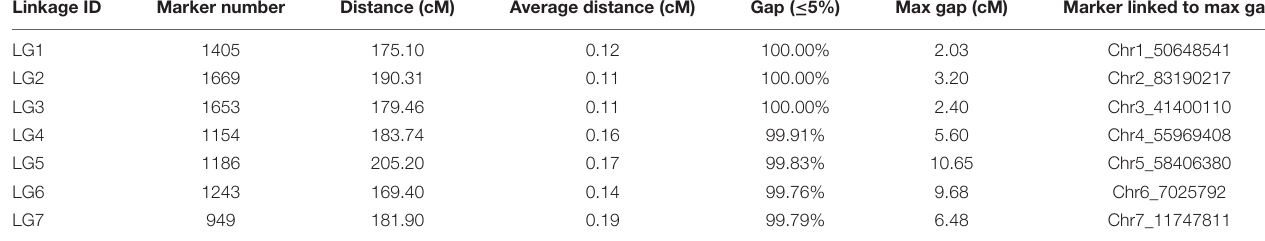
TABLE 4 | Summary of statistics for the linkage groups (LGs) of the genetic linkage map. Linkage ID